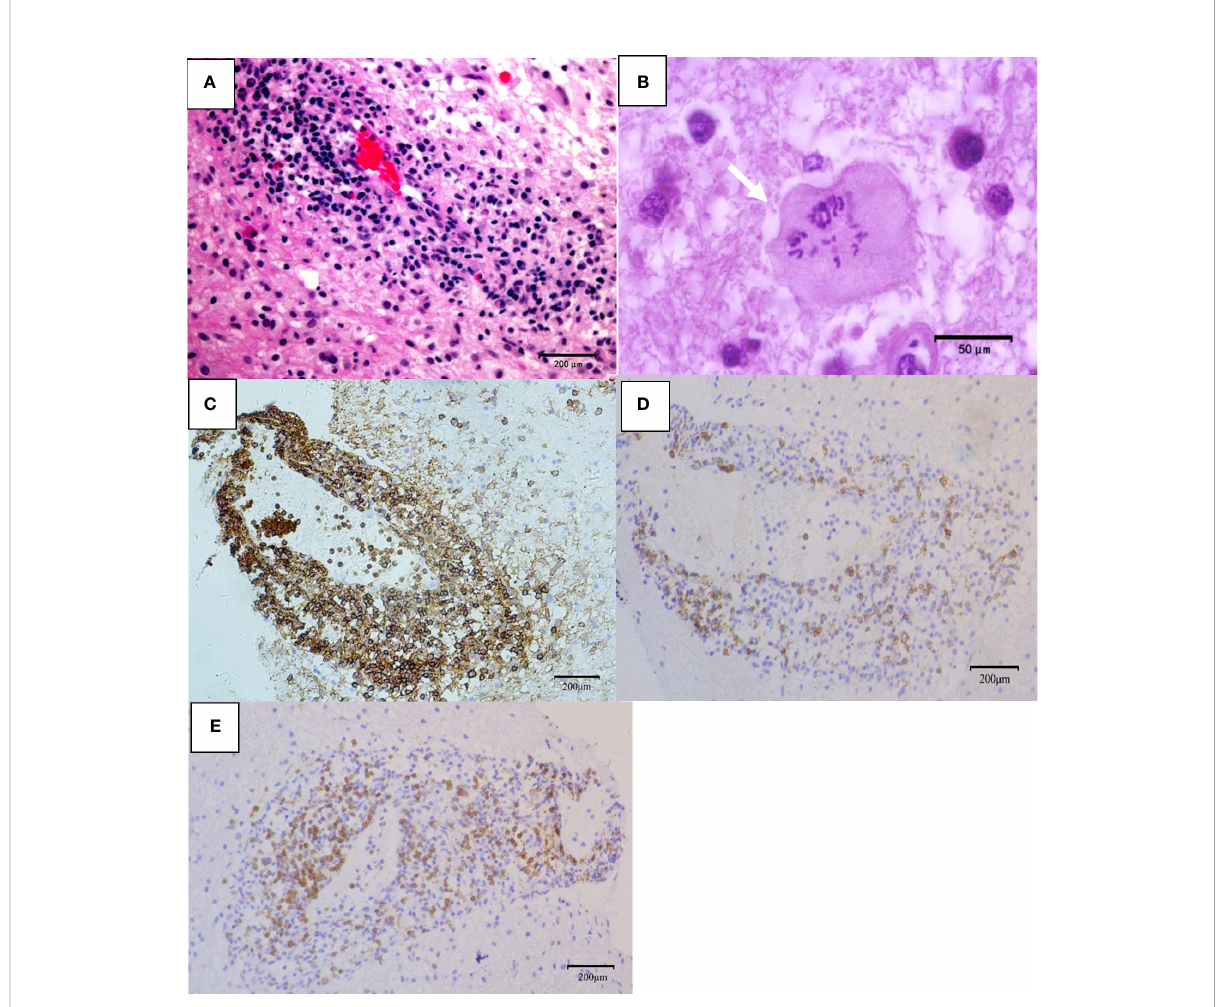
FIGURE 4 Pathological features of TDL. (A) Telangiectasia with hemorrhage and perivascular in fl ammatory cuff (hematoxylin and eosin, scale bar =200 m m); (B) Creutzfeldt-Peters cells (white arrow, hematoxylin and eosin, scale bar =50 m m); (C) LCA + lymphocytes around the blood vessels (LCA, scale bar =200 m m); (D) CD20 + B lymphocytes around the blood vessels (CD20, scale bar =200 m m); (E) CD3 + T lymphocytes around the blood vessels (CD3, scale bar =200 m